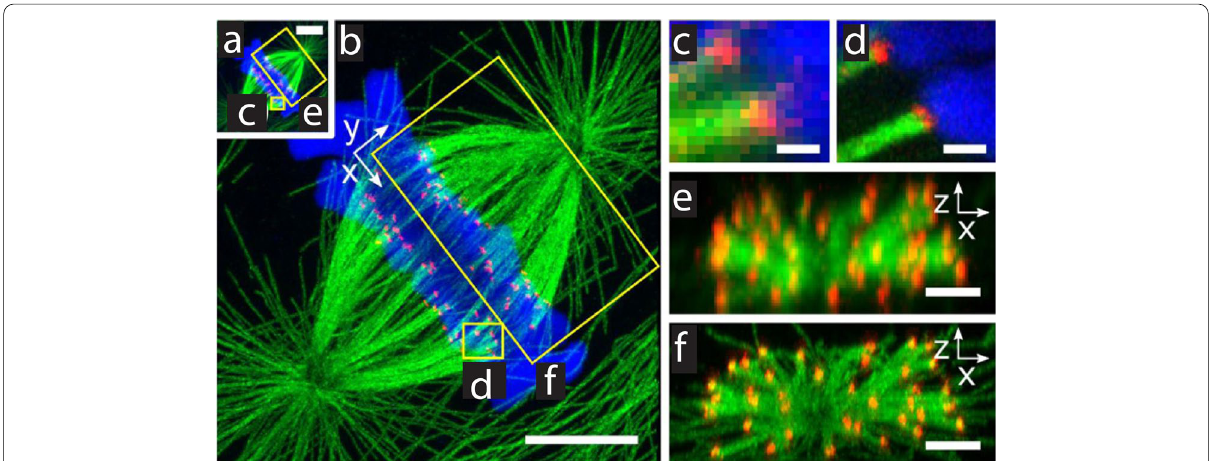
Fig. 6 Pre- ( a ) and post-expansion ( b ) images of a dividing PtK1 cell immunostained for tubulin (green) and the kinetochore protein HEC1 (red). Scale bar, 5 μm. c , d Magnified views of microtubule-kinetochore attachments from the boxed regions in a and b . Scale bars, 500 nm. e , f End-on views of the boxed regions in a and b . Scale bars, 2 μm. (Reprinted/adapted by permission from Springer Nature: Chozinski et al. [38], copyright